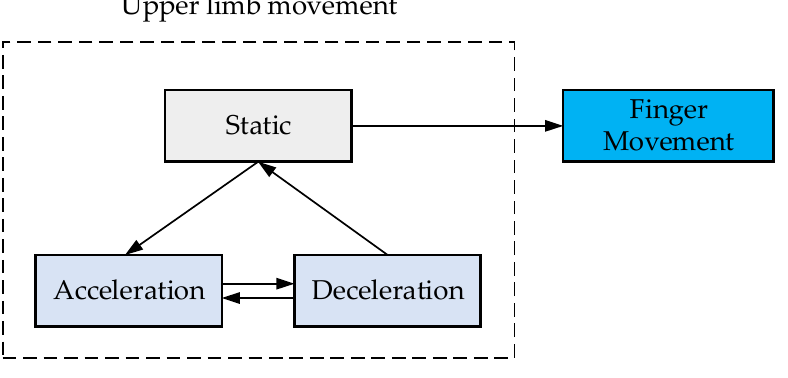
Figure 2. Switching flow chart of upper limb state .